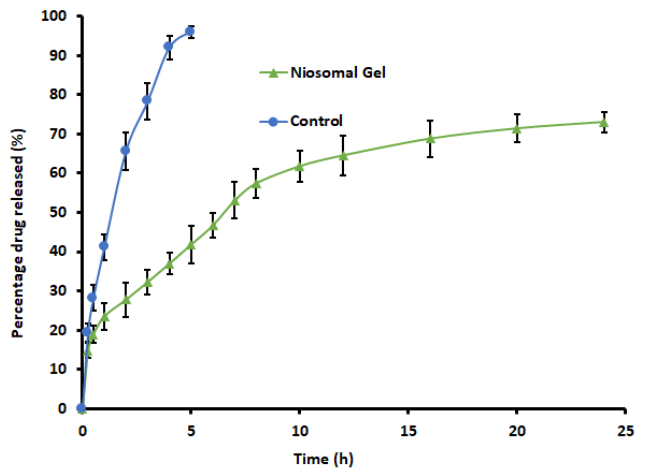
Figure 10. Comparison of release profiles of levosulpiride from niosomal gel and control gel. Each